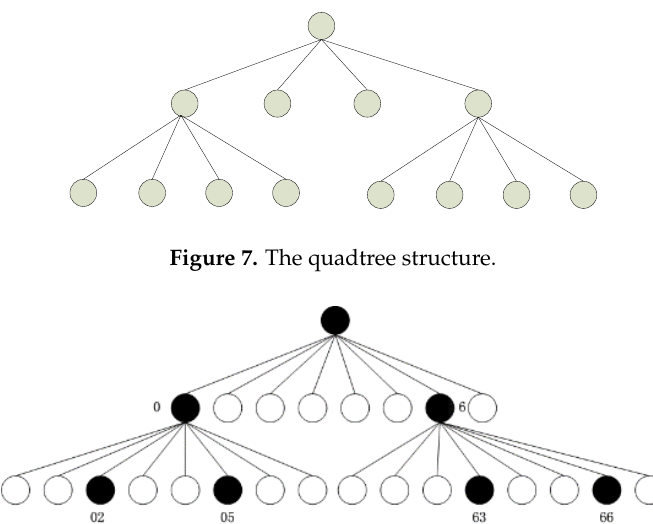
Figure 8. The octree structure.